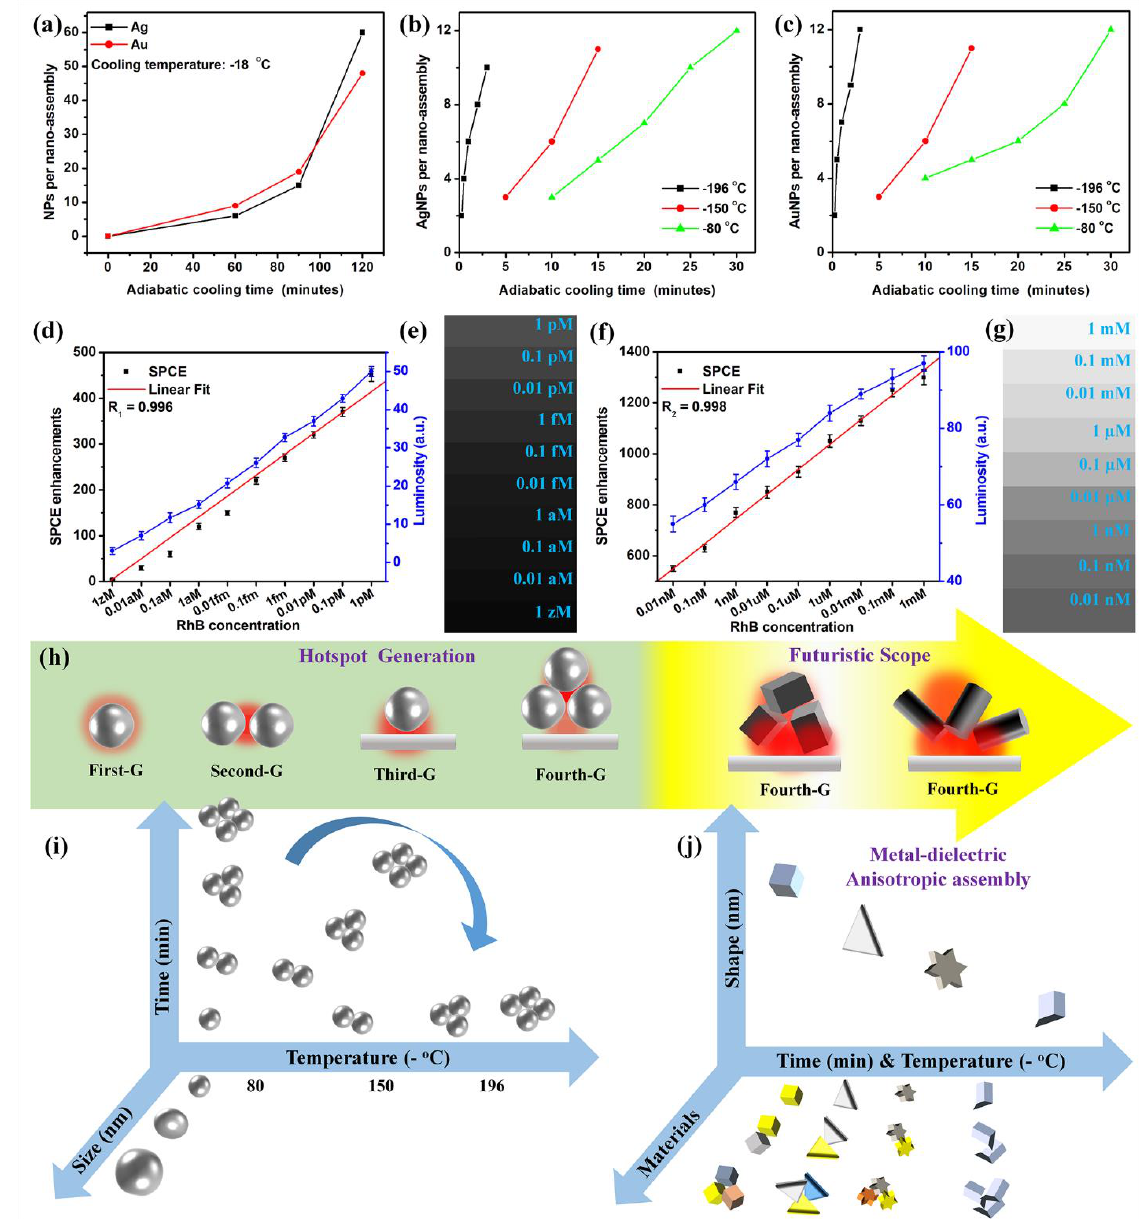
Figure 2. ( a ) AgNPs and AuNPs constituting a single assembly under − 18 ◦ C adiabatic cooling. ( b ) AgNPs constituting a single assembly under − 80 ◦ C, − 150 ◦ C and − 196 ◦ C adiabatic cooling. ( c ) AuNPs constituting a single under − 80 ◦ C, − 150 ◦ C and − 196 ◦ C adiabatic cooling. ( d , f ) Sensing of RhB presenting a single molecular limit of detection (zeptomolar). The corresponding luminosity values are presented in the right y-axis along with the respective shade cards shown in Figure ( e , g ), respectively. ( h ) The progress in diverse generations of hotspots in CSNE technology presenting opportunities for future explorations. ( i , j ) Snapshot of the plausible permutations and combinations of cryosoret-based nano-engineering available to the widespread community of nanotechnology and photo-plasmonics. Adapted with permission from